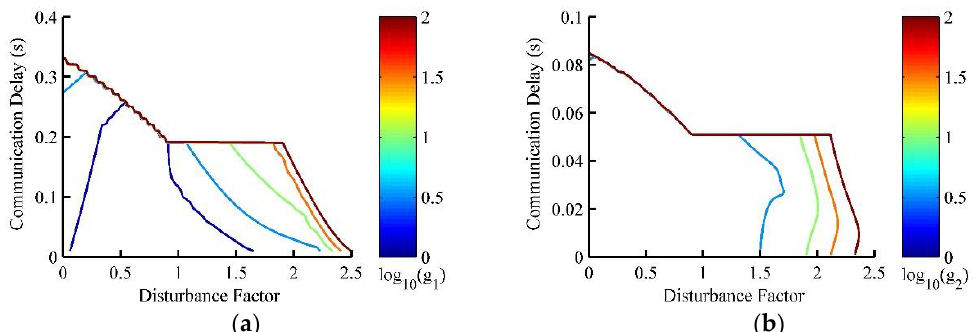
Figure 10. Robustness performance of platoon interacted by BD. ( a ) Maximum distance error of method 1. ( b ) Maximum distance error of method 2.